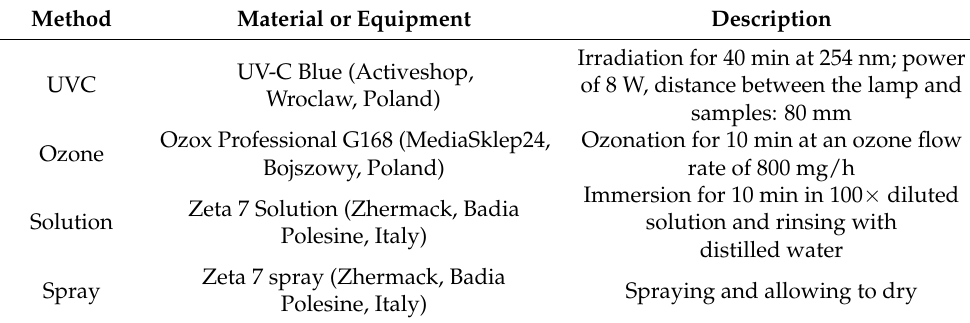
Table 2. Parameters of the disinfection methods applied in this